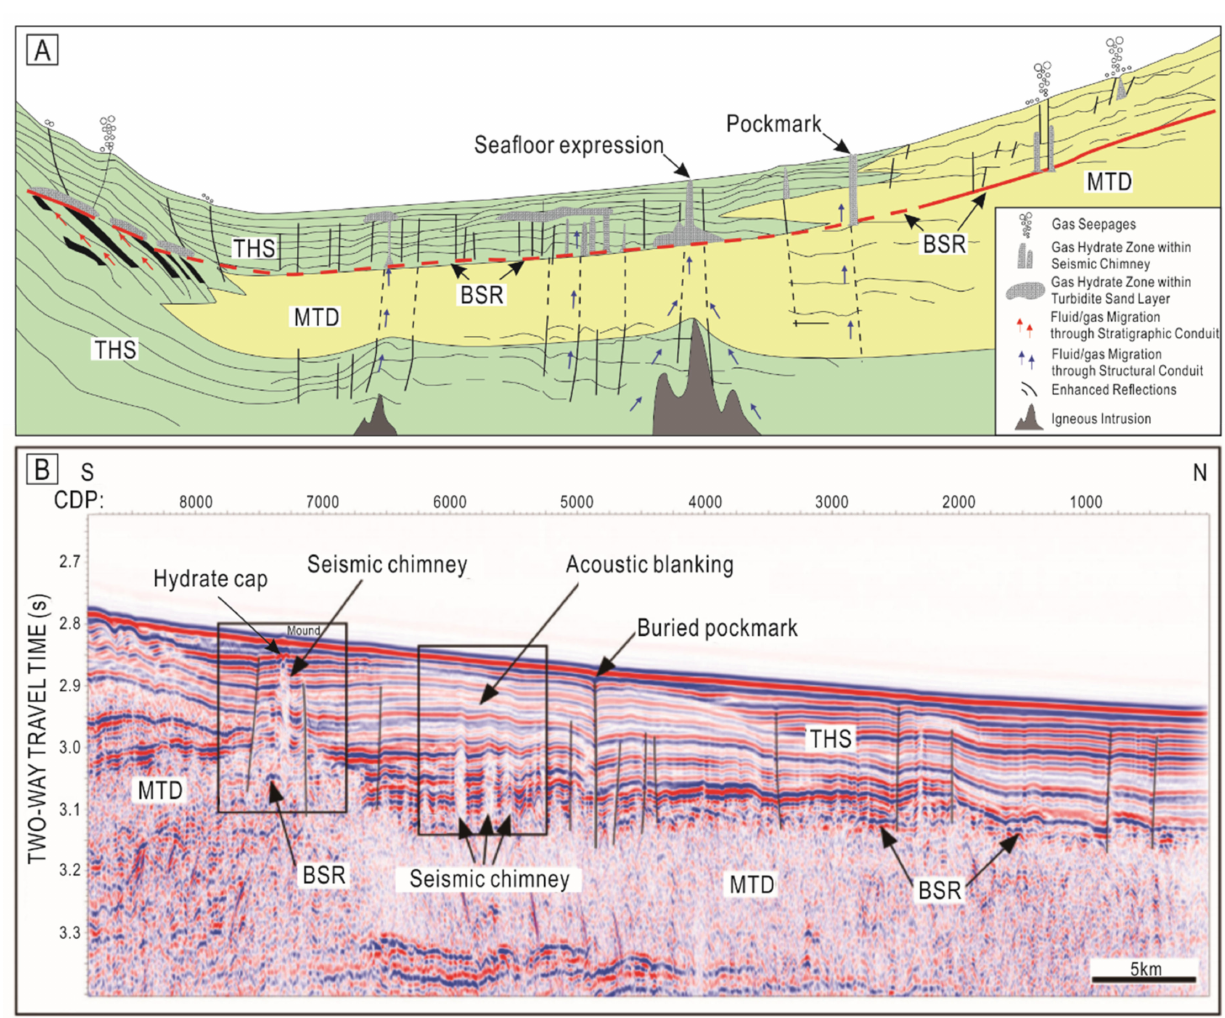
Figure 5. ( A ) Diagram illustrating gas migration and types of gas hydrates, and various related seismic signatures discovered in the Ulleung Basin. Note: Gas migrates into the GHSZ via two pathways: (1) Structural conduits, such as gas chimneys faults and fractures (blue arrows), and (2) stratigraphic conduits, such as inclined, permeable THS (red arrows) (cited from [22]). ( B ) An example seismic profile displaying seismic indicators including BSRs, acoustic blanking, and gas chimneys (modified from [22]). Note: MTD: Mass transport deposits; THS: Turbidite–hemipelagic